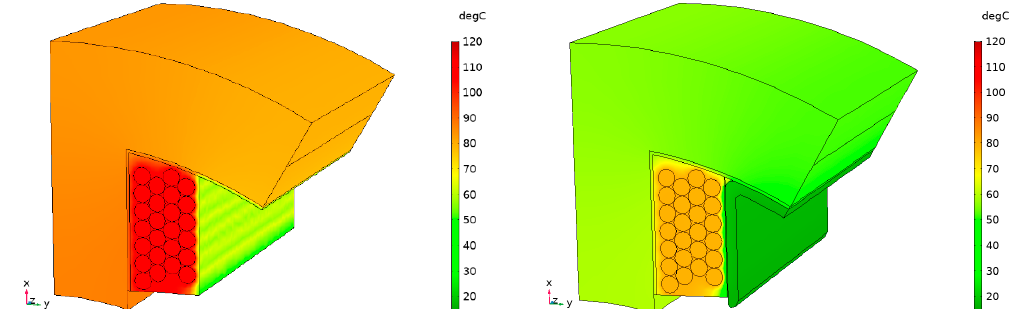
Figure 7. Temperature distribution for DCC1 ( left ) and DCC2 ( right ).